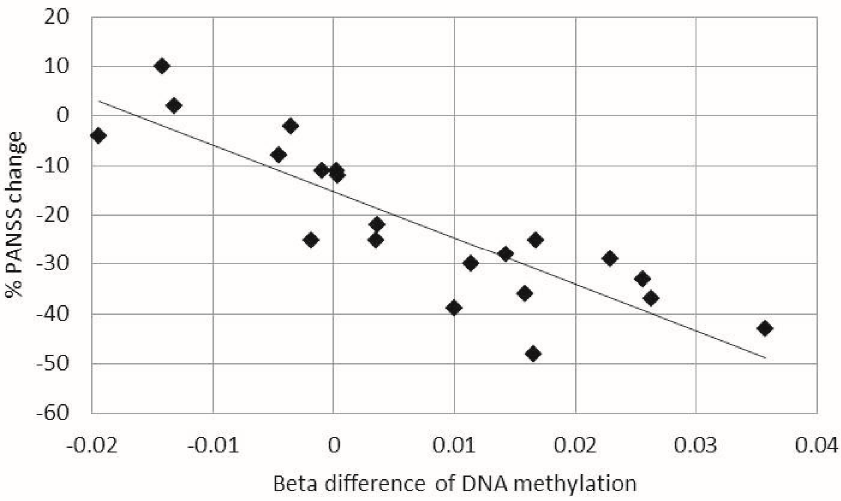
Figure 3. The correlation between beta difference of DNA methylation changes in the CREBBP gene and % Positive and Negative Syndrome Scale (PANSS) changes. X axis represents beta difference of DNA methylation in the CREBBP gene (cg05151055). Y axis represents % PANSS changes. Each dot represents samples. Significant negative correlation between beta difference of DNA methylation in the CREBBP gene and % PANSS changes was observed ( p = 2.7 × 10 − 7 ).